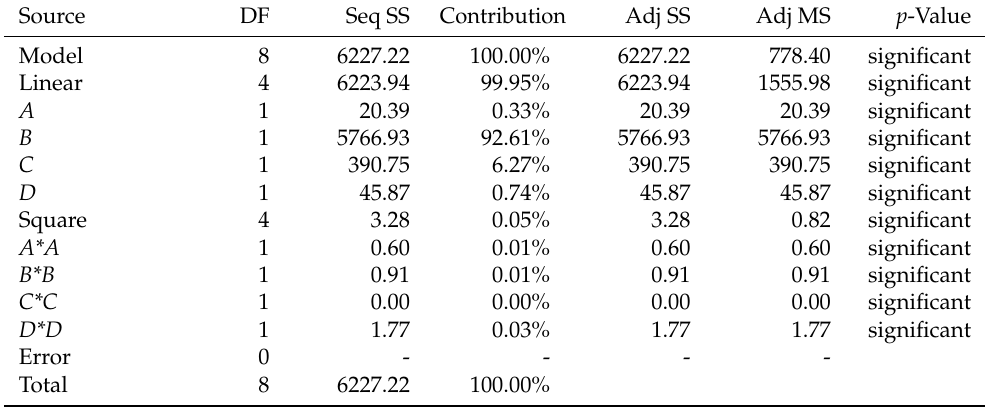
Table 7. ANOVA for